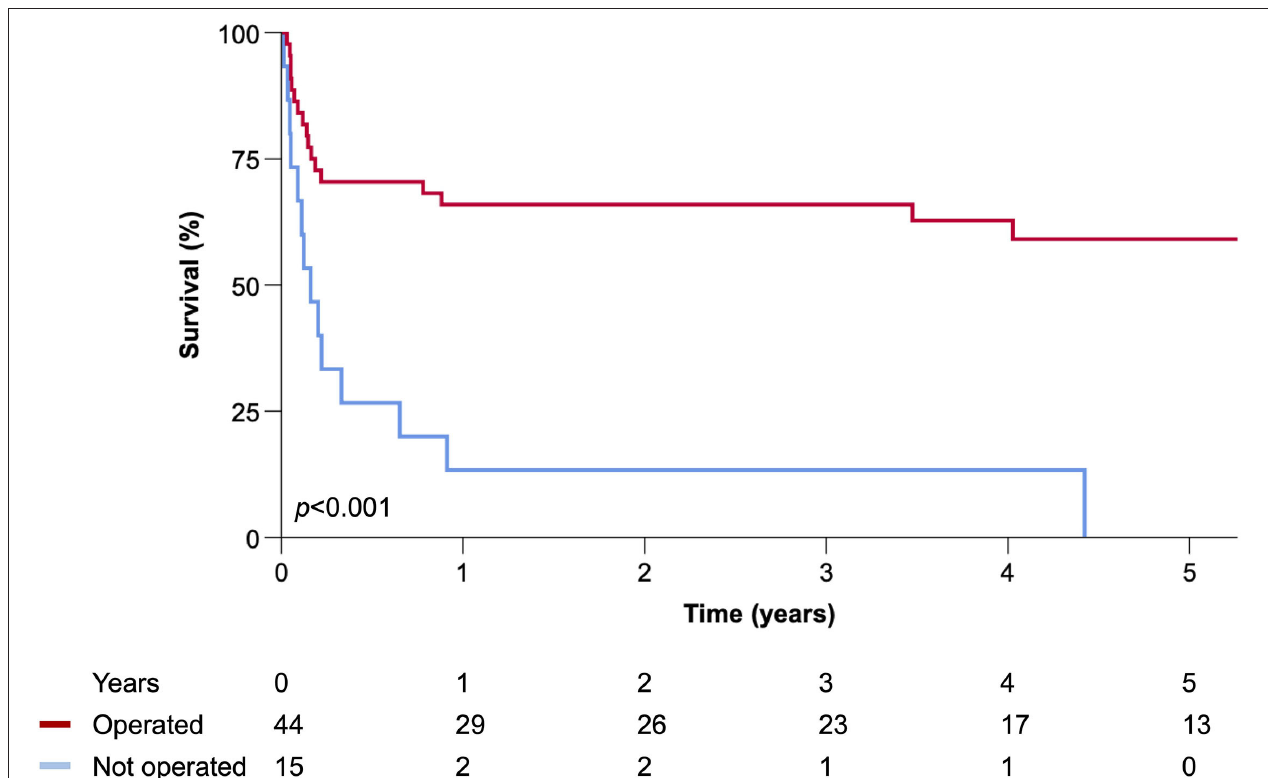
FIGURE 3 | Kaplan–Meier plot of all-cause mortality comparing operated and non-operated